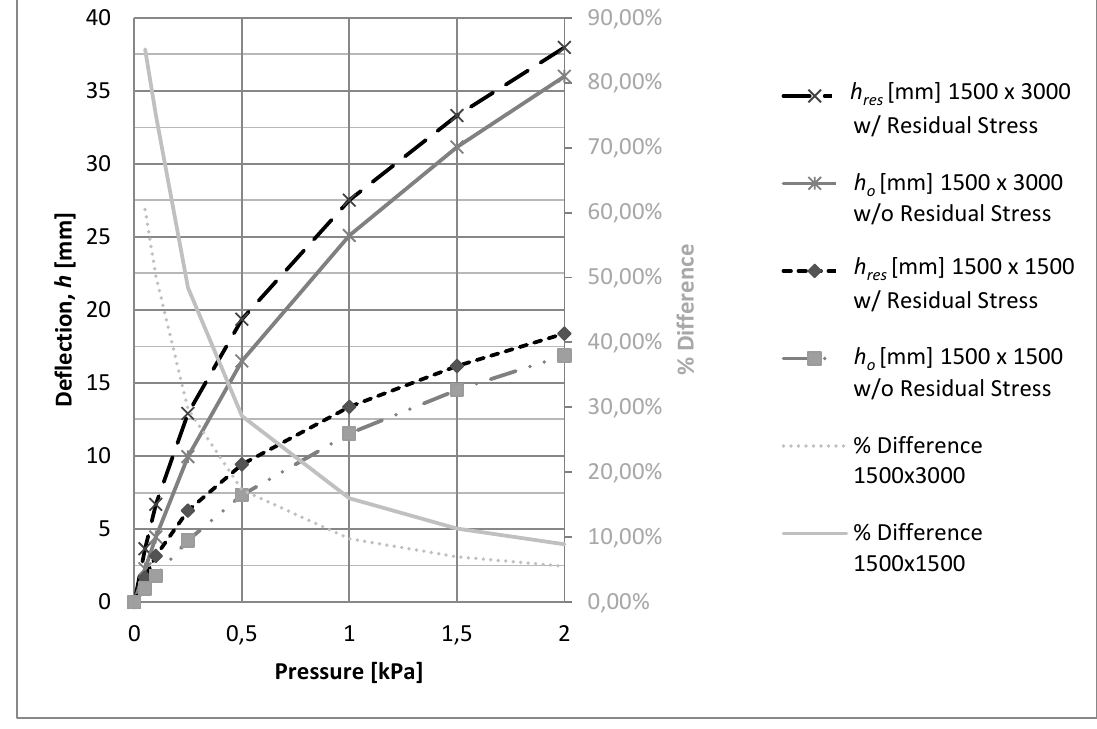
Fig. 11 Comparison of transverse deflection with and without inclusion of warping residual stresses This loss is at its highest percentage for the lower transverse pressures, but is still pronounced even at the higher levels of lateral pressure. The light gray lines, plotted against the secondary axis in Figure 11 provide the percent difference between the cases with and without residual stress. The percent difference between deflection with and